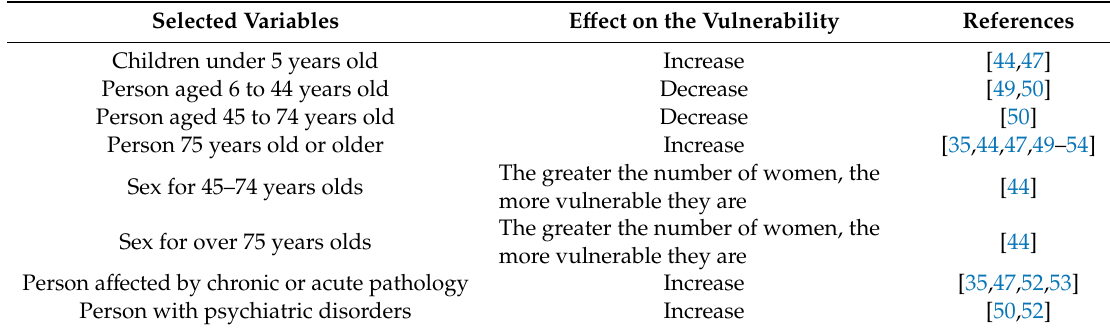
Table 1. Variables used in the assessment of physiological vulnerability to heat wave hazard. Selected